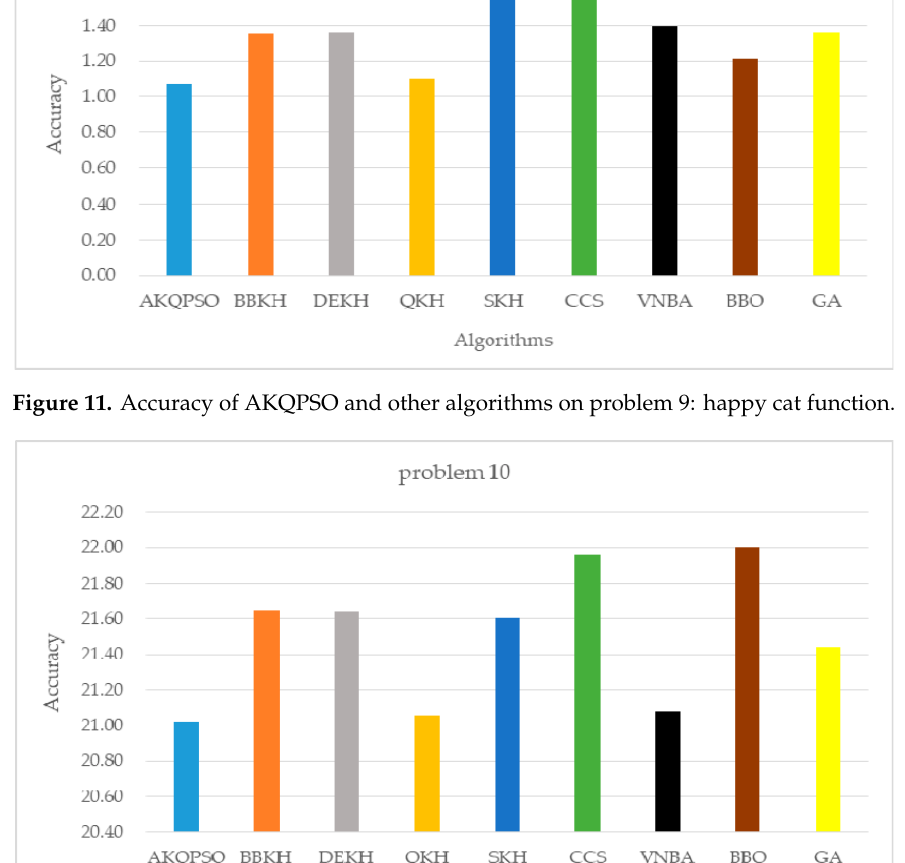
Figure 12. Accuracy of AKQPSO and other algorithms on problem 10: Ackley function.